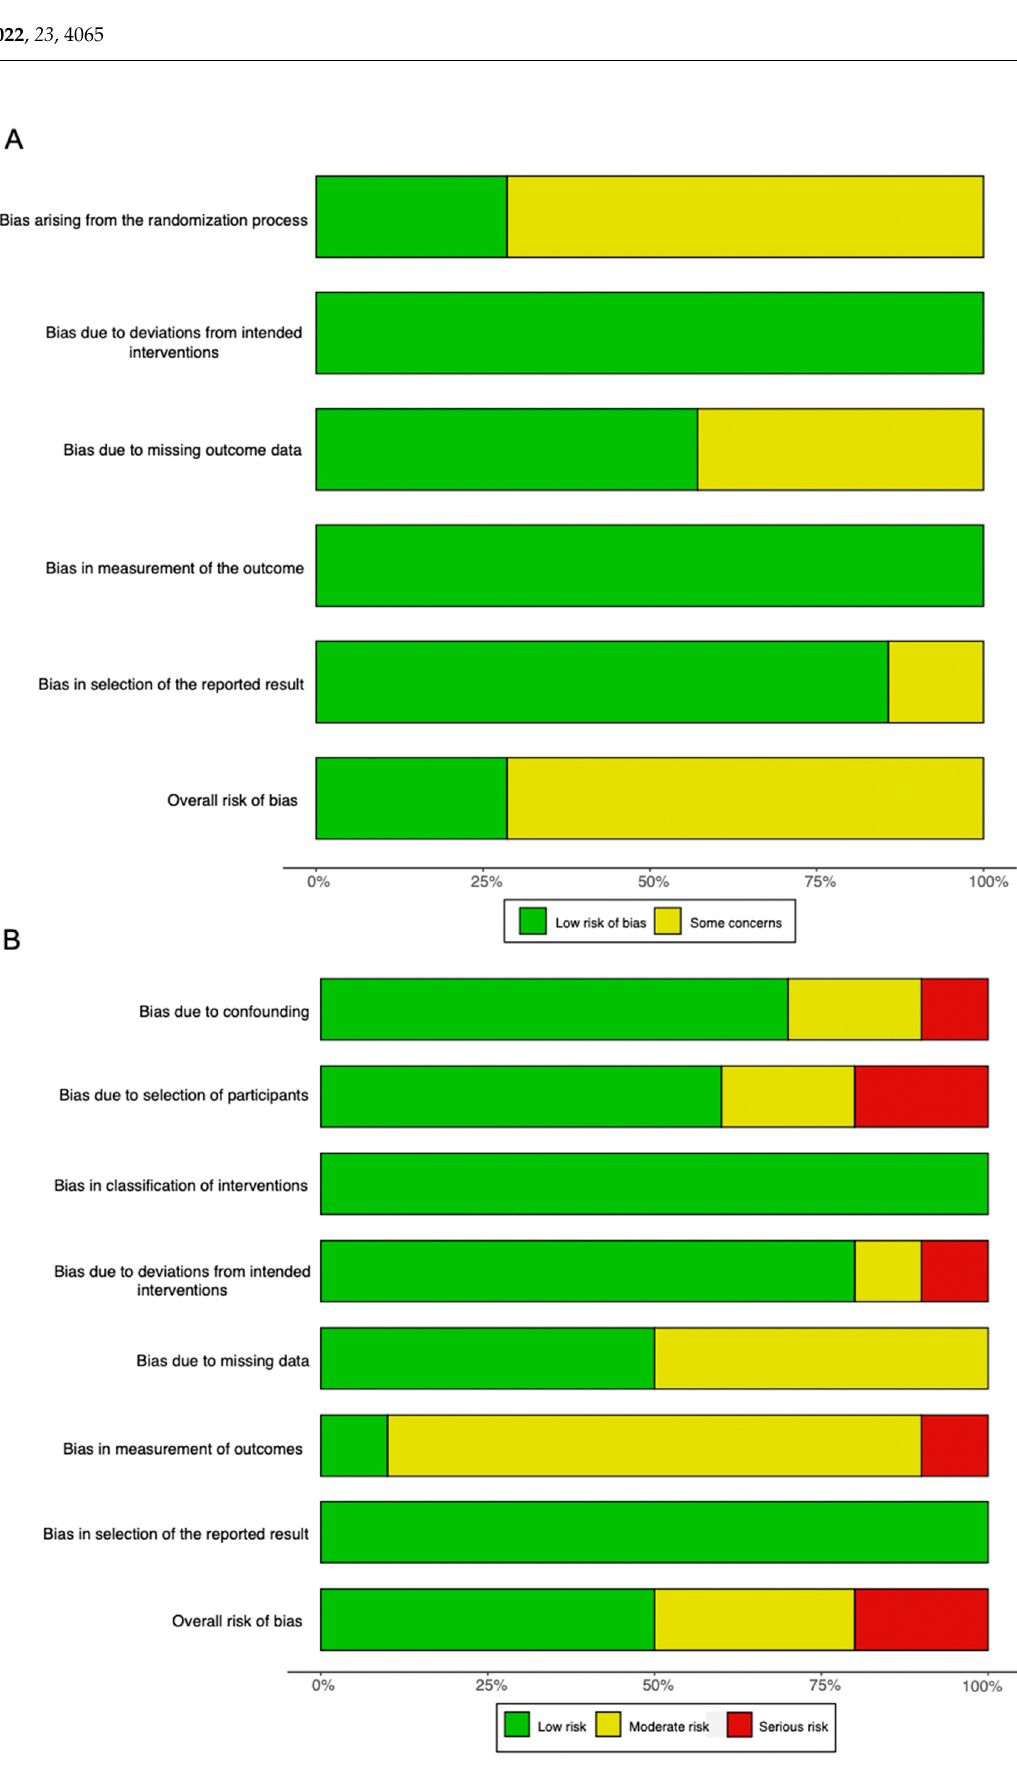
Figure 7. Summary graphs showing the overall risk of bias analysis using ( A ) the RoB 2.0 tool in randomized studies and ( B ) the ROBINS-I tool in non-randomized studies.